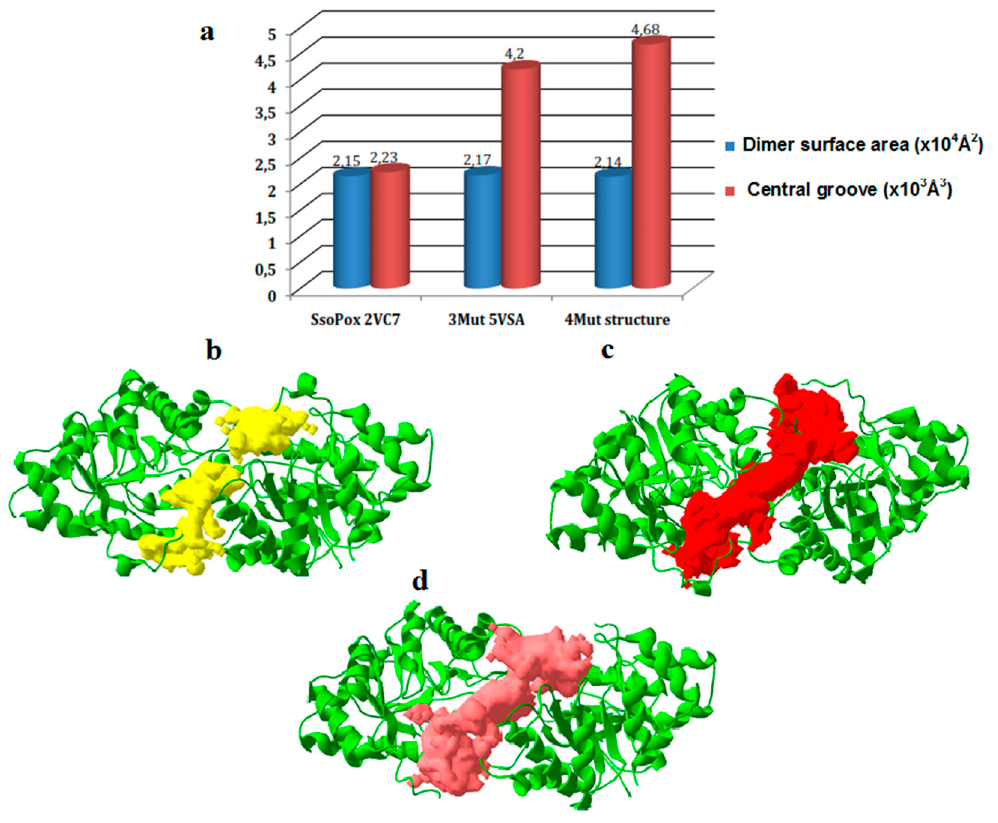
Figure 7. Analyses among Sso Pox, Sso Pox 3Mut and 4Mut. ( a ) Dimer surface area and central groove volume of ( b ) Sso Pox 3D structure (PDB: 2VC7), ( c ) 3Mut structure (PDB: 5VSA and ( d ) 4Mut 3D structure.